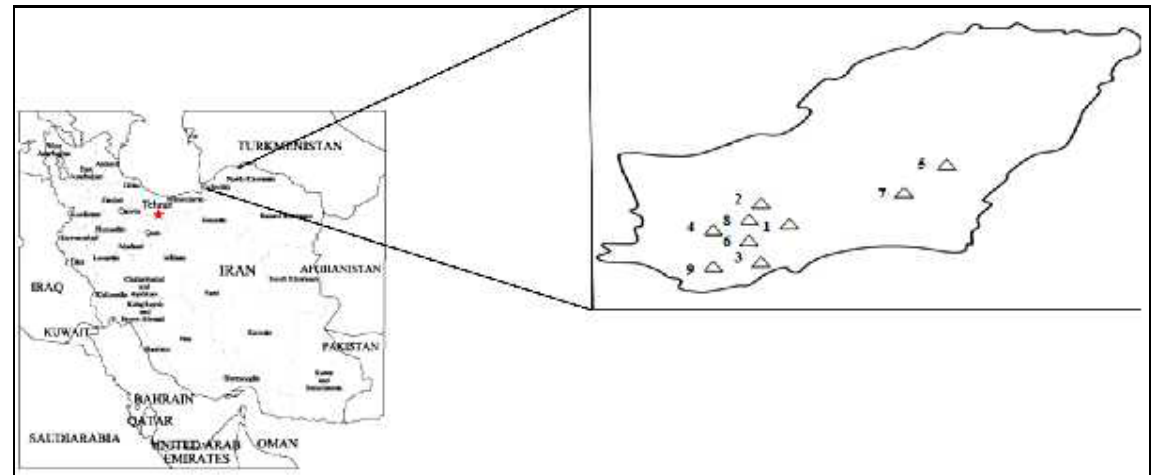
F IGURE 1. Distribution of sampling localities in Golestan province (The number correspond to